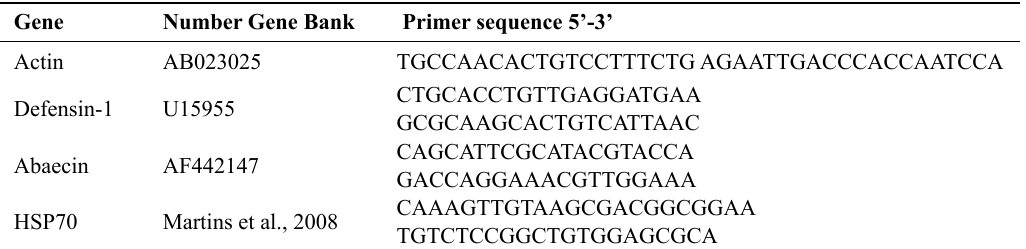
Table 1. Oligonucleotides initiating immune system genes (defensin-1, abaecin, and HSP70) and constituent (actin) of honeybees submitted to different transportation time